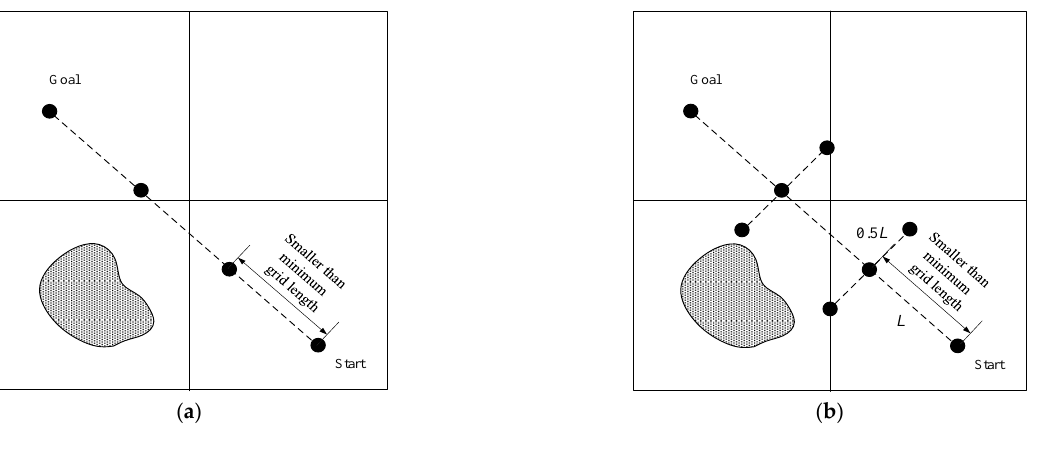
Figure 2. Two sight line discretization scheme. ( a ) Simple sight line discretization (sometimes obstacle node cannot be detected). ( b ) Safe sight line discretization (obstacle node is guaranteed to be detected).